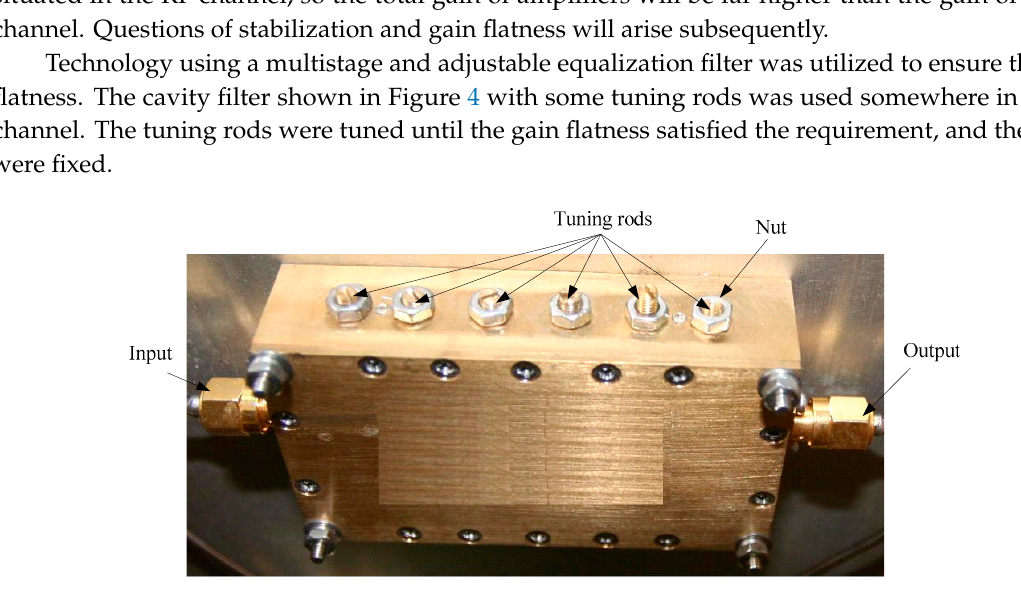
Figure 4. Example of the cavity filter with some tuning rods.